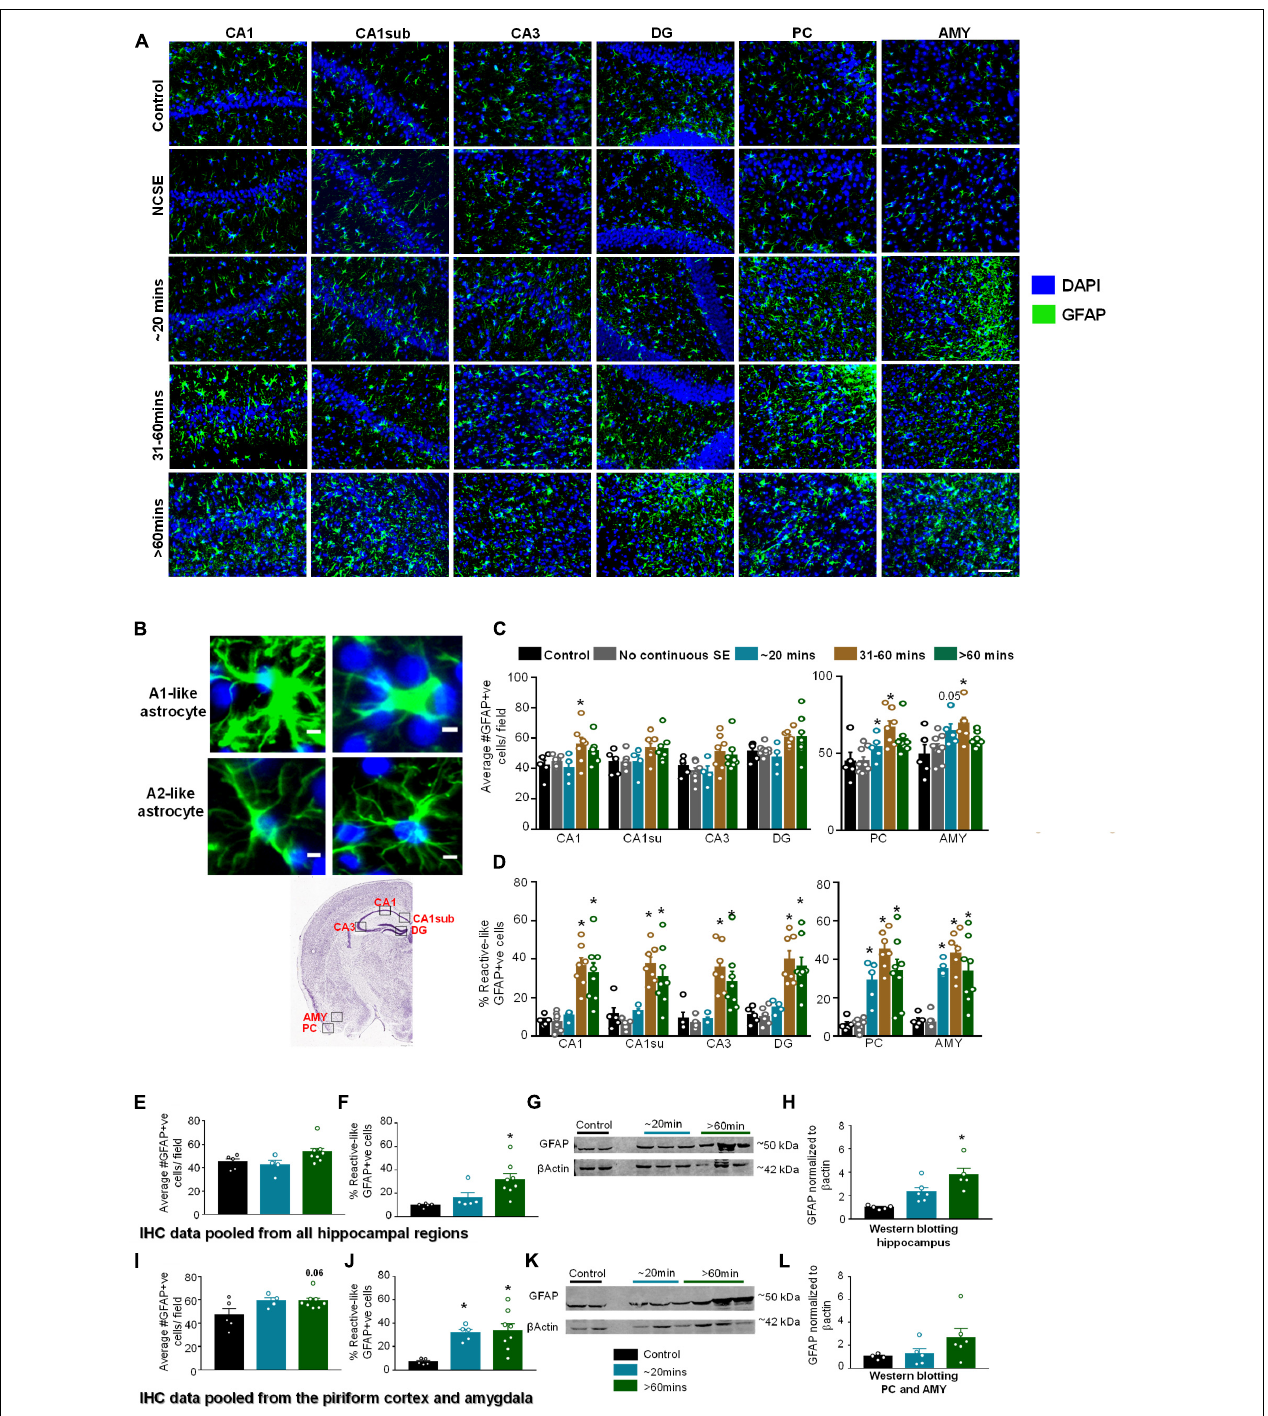
FIGURE 6 | Impact of SE severity and duration on astrogliosis. (A) Representative images of the hippocampus (CA1, CA1 close to the subiculum = CA1sub, CA3, DG), piriform cortex (PC) and amygdala (AMY). (B) Examples of reactive (A1-like, large cell bodies, short and thick processes) and non-reactive (A2-like) GFAP positive cells. (C) Average number of GFAP positive cells, and (D) percent GFAP positive cells with reactive (A1) like morphology (mixed measures ANOVA, n = 5-9). (E,F) Pooled data from the hippocampus showing the number of GFAP positive cells (E) and GFAP positive cells with reactive morphology (F) . (G,H) Western blotting of hippocampal lysates for GFAP (ANOVA, n = 4-6). (I,J) Pooled data from the amygdala/piriform cortex for number of GFAP positive cells (I) and GFAP positive cells with reactive morphology ( J , ANOVA, n = 5-8). (K,L) Western blotting of PC/AMY lysates for GFAP (ANOVA, n = 4-6). Error bars indicate standard error of the mean. Scale, 100 µ m (A) and 5 µ m (B) . * p < 0.05 compared to control. Both graphs- mixed effects ANOVA, n = 5-12. Area counted = 0.14 mm 2 Atlas Image credit: Allen Institute, United